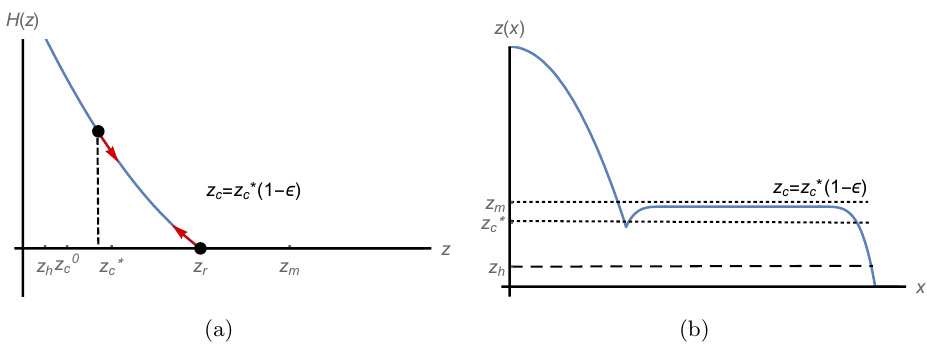
Figure 2 . For z 0 < z c = z (cid:3) (1 (cid:0) (cid:15) ) where 0 < (cid:15) (cid:28) 1 and z t ! 1 , H ( z r ) = 0, where z r is slightly less c c than z m . H ( z ) decreases from z = z c to z = z r as shown in (a), which means z ( x ) increases from z c to a maximum z r and then decreases to zero. The corresponding con(cid:12)guration of the critical surface is shown in